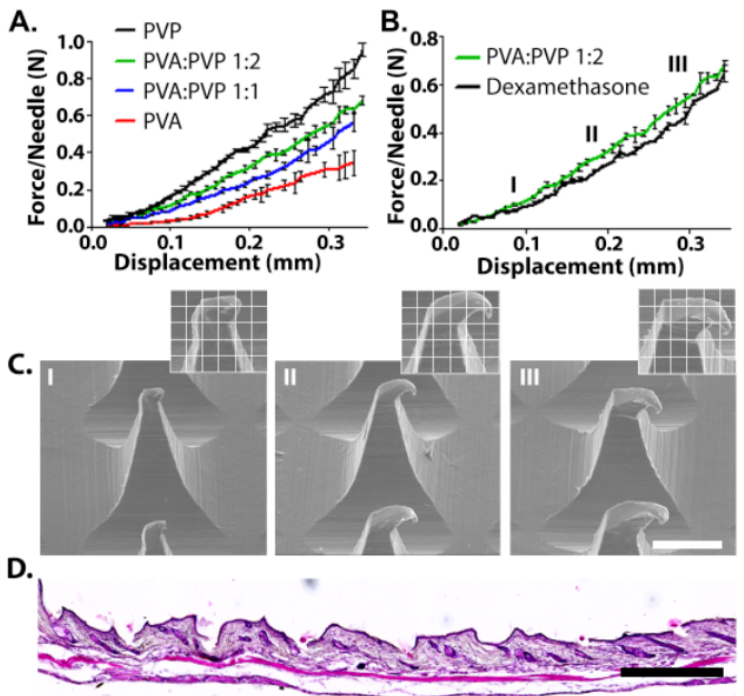
Figure 2. ( A ) Compression behavior of microneedles made from di ff erent ratios of PVA/PVP. ( B ) 0.25% Dex in 1:2 PVA/PVP MNs compared with empty MNs. ( C ) Representative SEM images of Dex-MNs after compression at selected points (I,II,III). Scale bar: 200 µm. ( D ) Histological examinations of mice skin after MN insertion. Scale bar: 500 µm.